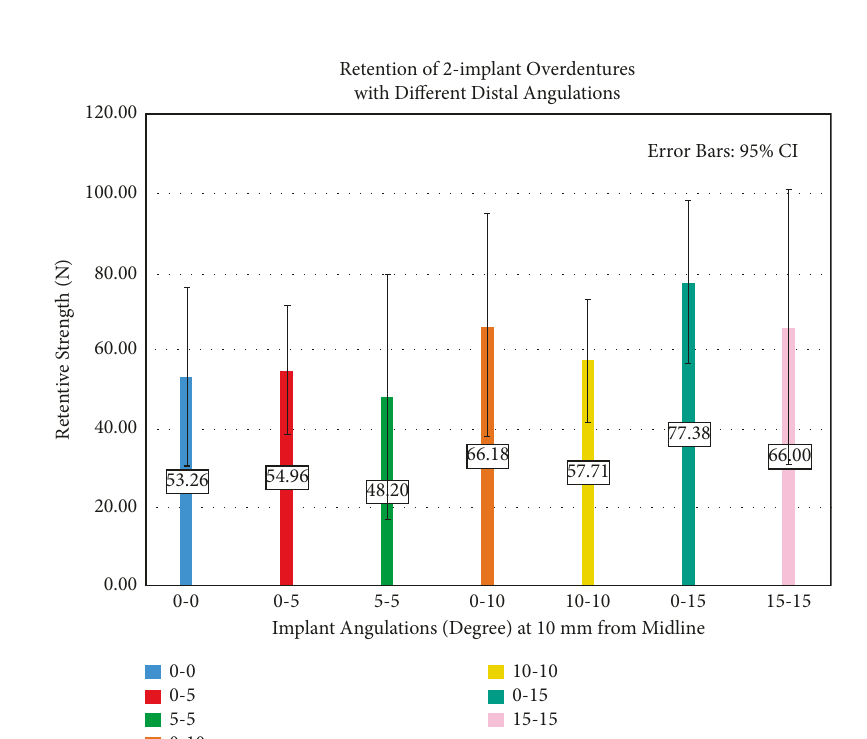
Figure 4: Retention of 2IMO with different implant